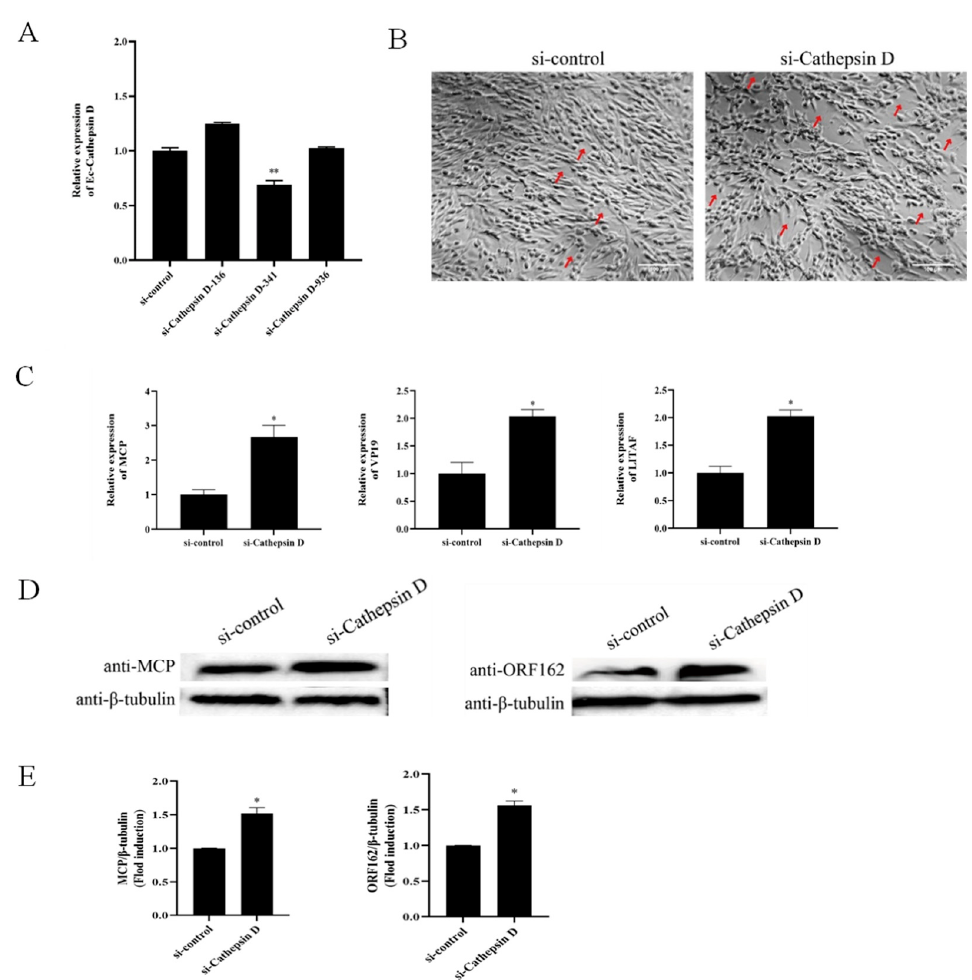
D- transfected cells (Figure 5D,E). These data indicated that Ec-CD knockdown promoted SGIV infection.